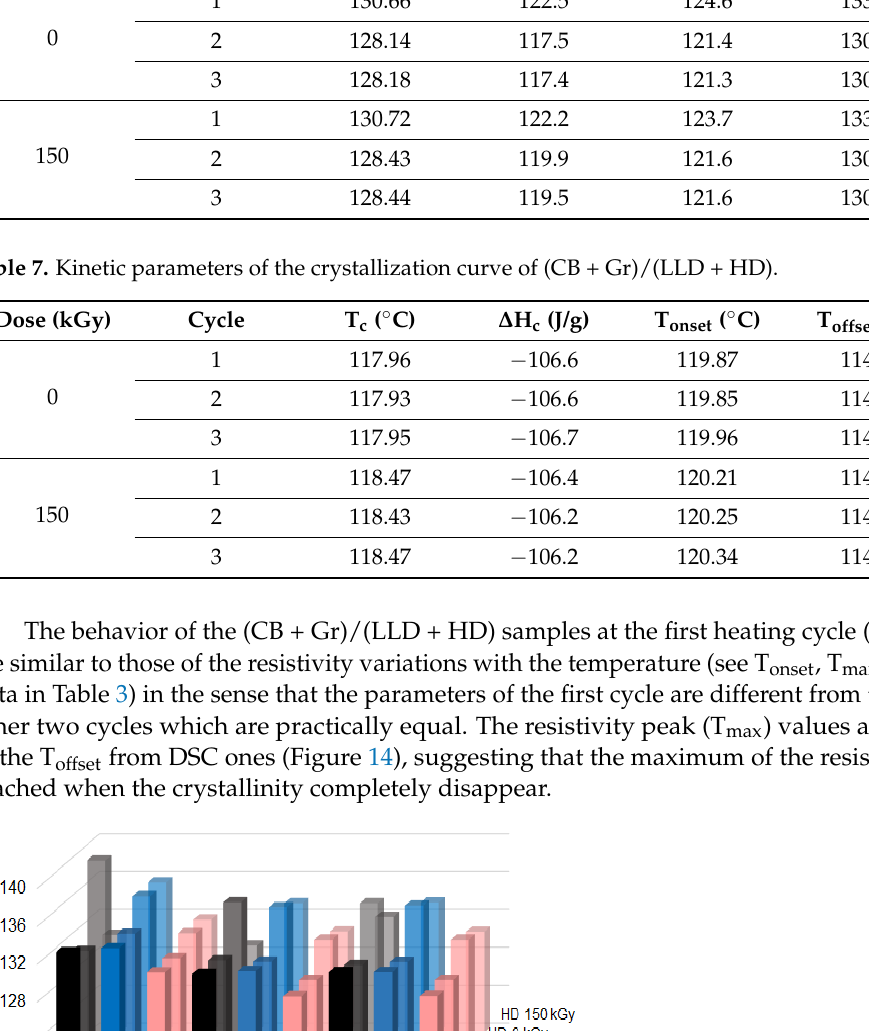
Table 6. Kinetic parameters of the melting curve of (CB + Gr)/(LLD + HD).